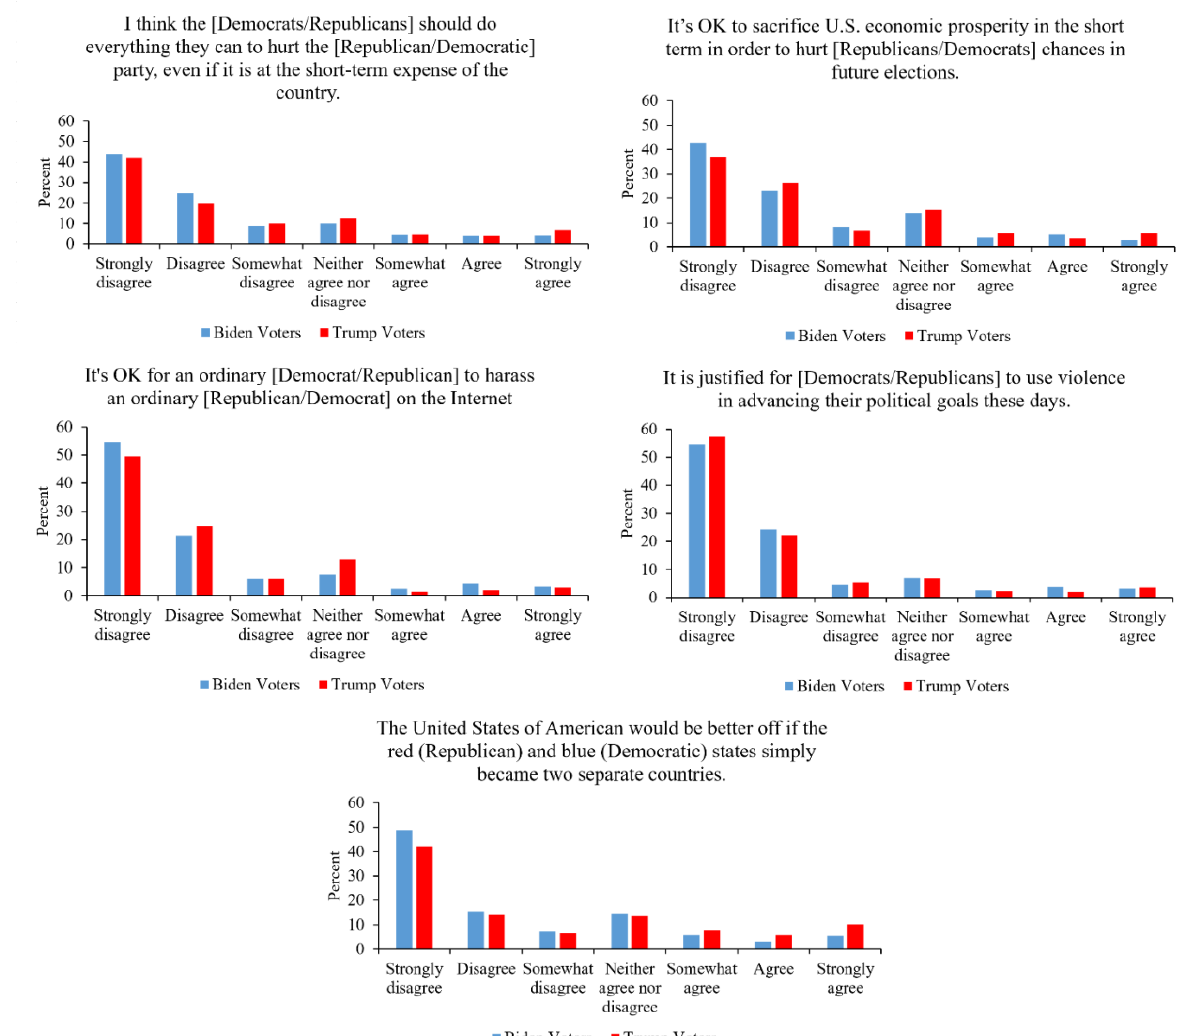
Figure 4. Forecasted behavior following the inauguration. Percent of Biden (blue) and Trump (red) voters forecasting different reactions to the hypothetical of Biden becoming President despite a lack of concession from Trump. Note that the question wording was not exactly as stated in the figure .